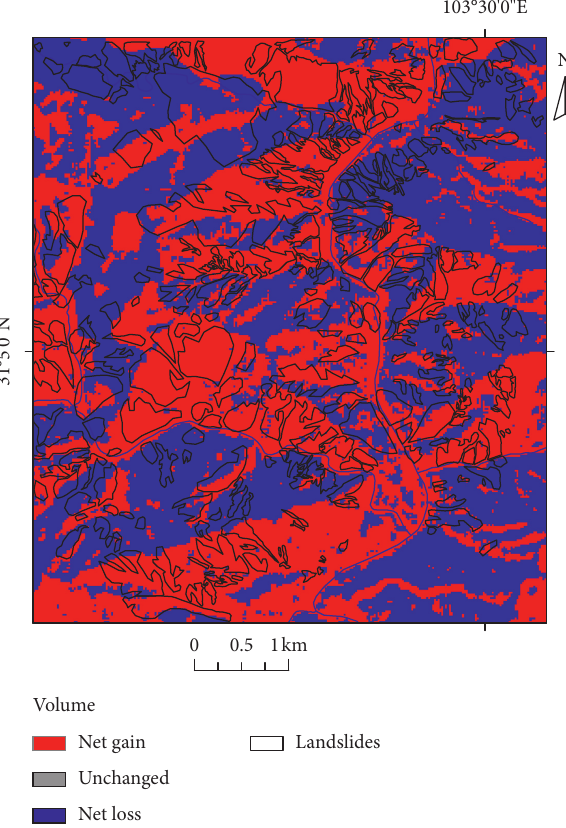
Figure 3: Net gain and net loss in the study area obtained by using the cut-fill tool of ArcGIS.